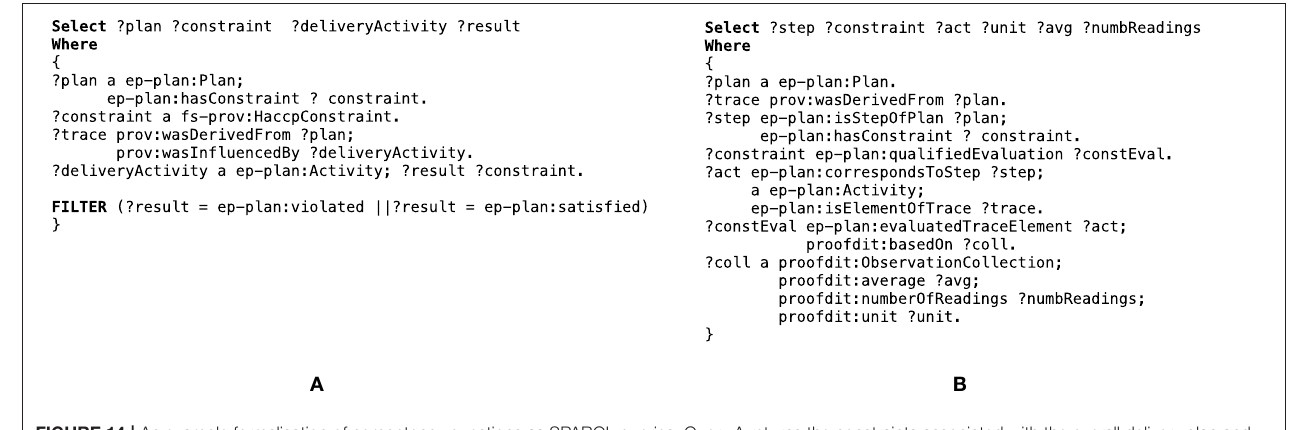
FIGURE 14 | An example formalisation of competency questions as SPARQL queries. Query A returns the constraints associated with the overall delivery plan and whether these were satisfied by the delivery activity. Query B returns the details on how a specific constraint was evaluated based on sensor